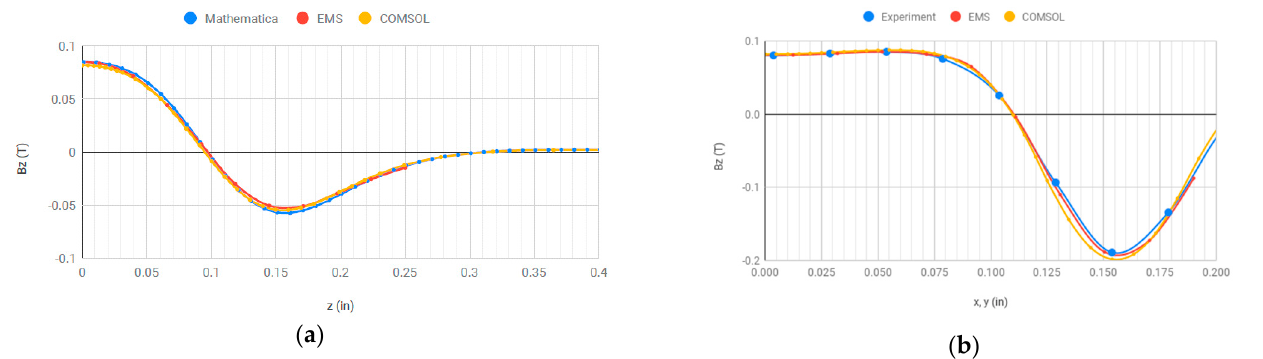
Figure 11. B z Combined plots—origin at symmetry axis: ( a ) longitudinal (z-axis); ( b ) transverse (x-axis). Experiment values are measured with a transverse Gauss meter mounted to a micrometer-controlled translation stage.